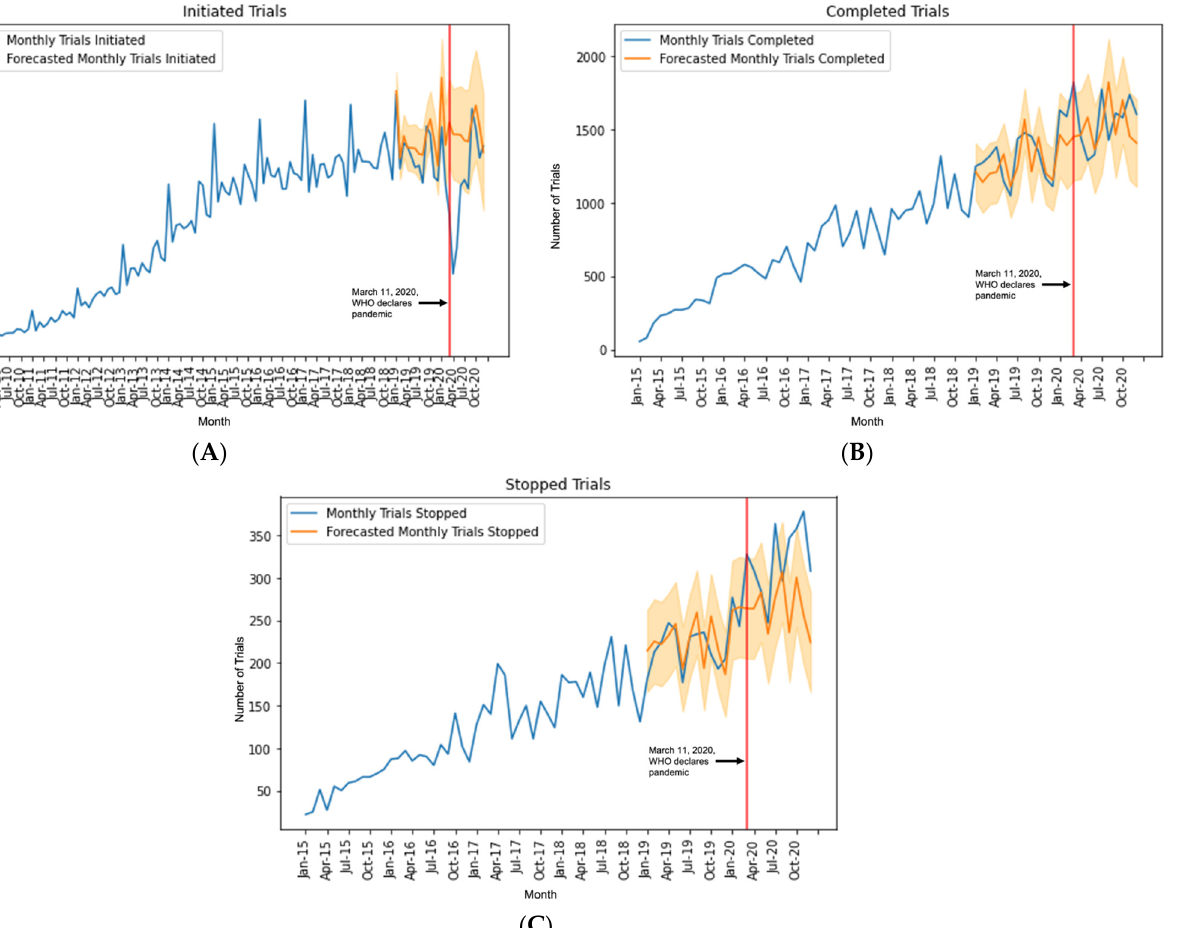
Figure 3. Trends in monthly trial ( A ) initiation, ( B ) completion, and ( C ) stoppage before and after declaration of the COVID-19 pandemic. Actual number of trials (blue line) and predicted trials (orange line). The orange shading represents the forecast’s 95% confidence intervals.